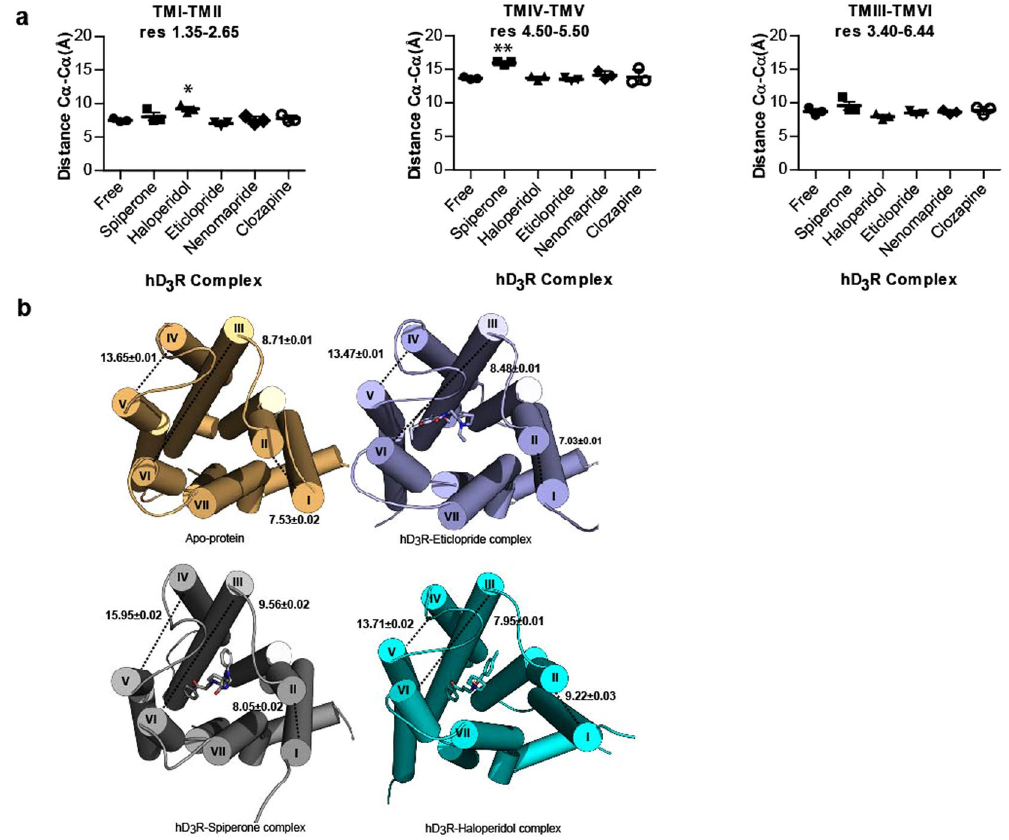
Figure 10. Molecular dynamics simulations indicate that binding of spiperone and haloperidol induces distinct conformational changes in the tertiary structure of hD 3 R. Molecular dynamics simulations of the hD 3 R apo-protein, or hD 3 R bound with eticlopride, spiperone, haloperidol, clozapine or nemonapride were run for 500 ns. ( a ) Comparison of the distances between the residues located at positions 1.35 and 2.65 in TMD I-TMD II, 3.40 and 6.44 in TMD III-TMD VI and 4.50 and 5.50 in TMD IV-TMD V in the hD 3 R is shown. Data are means ± SEM from n = 3 experiments, with the average value from each experiment shown, * p < 0.05; ** p < 0.01 when compared with the apo-protein. See Results for details of quantification. ( b )